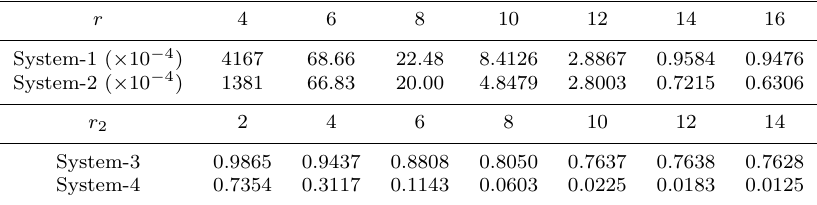
Table 2. Computational time (s) of obtaining reduced systems in Example 1.